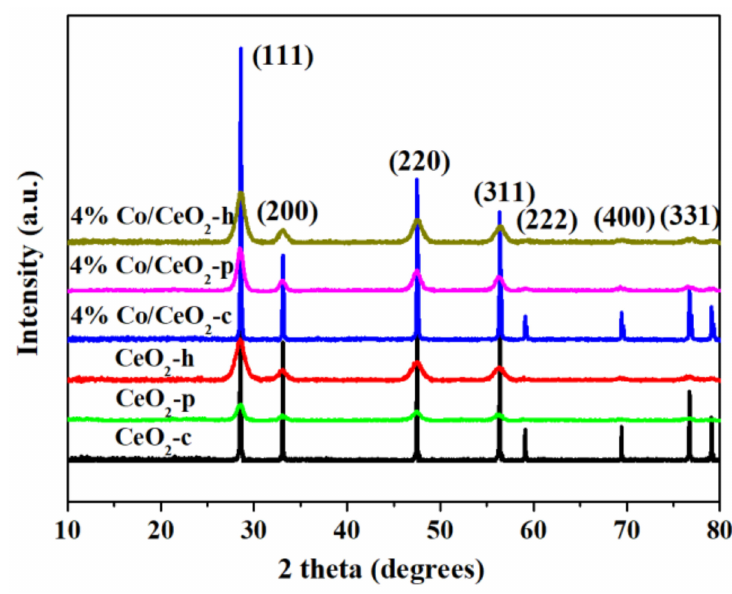
Figure 4. XRD patterns of CeO 2 supports and Co / CeO 2 catalysts.